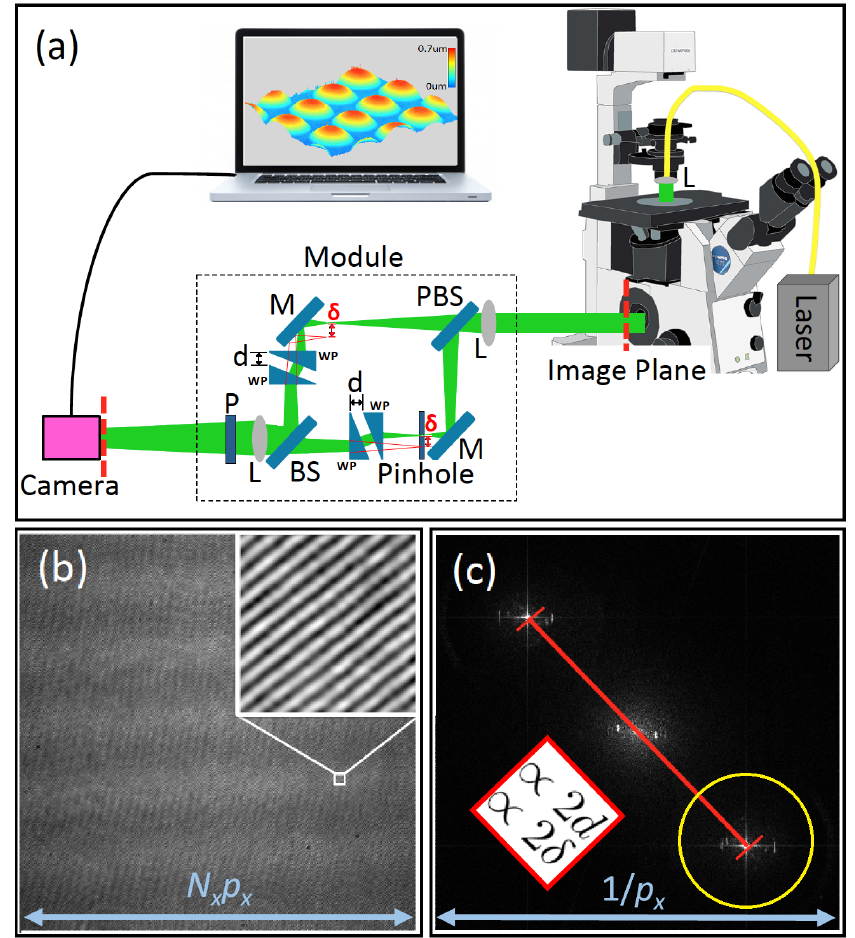
Figure 1. ( a ) Optical setup of off-axis digital holographic microscopy using the self-reference module proposed in this paper. L: Lens; P: Polarizer; BS: Beam-splitter; M: Mirror; WP: Wedge Prism. Full details on specific components is provided in Section 2.2. The module is placed at the output port of an existing microscope and an inexpensive laser is used to illuminate the sample. Two wedge–prism pairs with spatial separation, d , are used to shift the object and reference beams in opposing directions in the Fourier domain by an amount δ . A pinhole is used to obtain a plane reference wavefield which interferes with the object wavefield on the camera face; ( b ) part of the interference pattern recorded of a micro-lens array using a digital camera with N x pixels of size p x in the x -dimension; ( c ) the discrete Fourier transform of this intensity pattern showing the separation of the twin image terms; the real image term, highlighted in yellow, is spatially filtered in order to reconstruct the complex object wavefield. The separation between the twin image terms is shown by the red line and is proportional to the distance between the wedge prism pairs, d . The separation and can be adjusted to match any particular camera pixel size, p x , the inverse of which defines the bandwidth of the